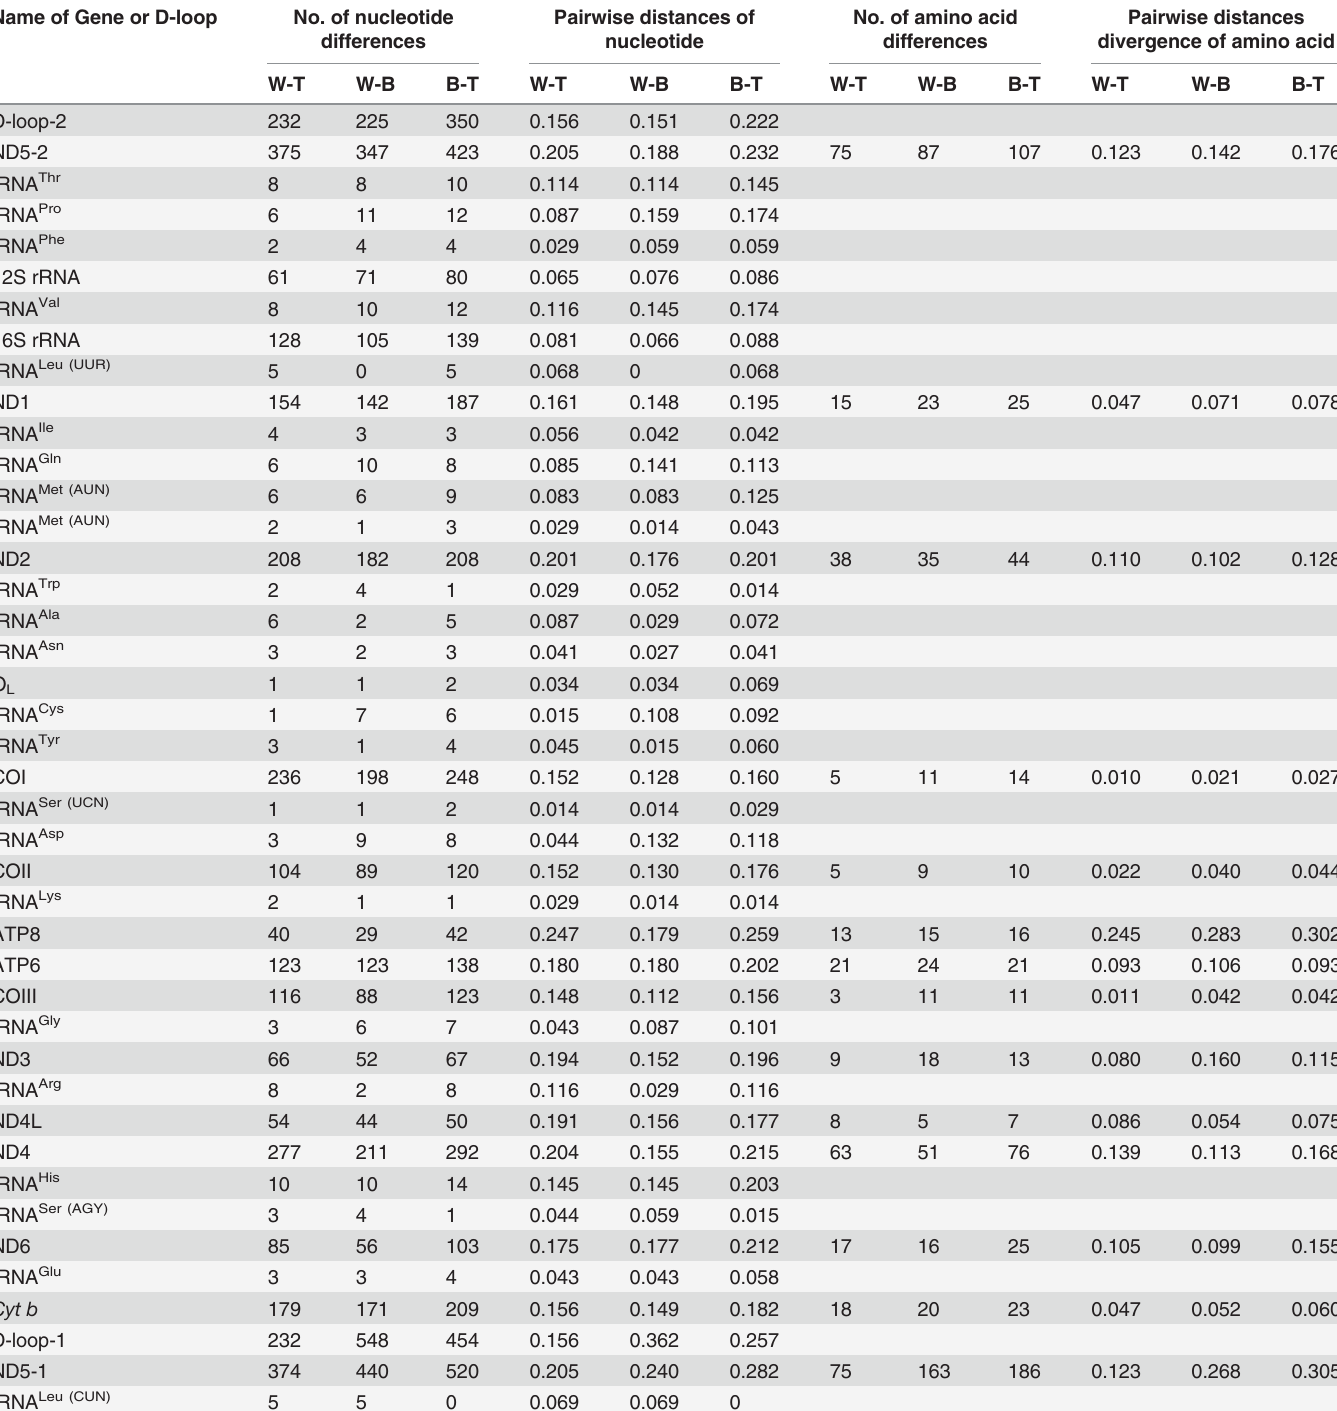
Table 4. Statistics describing the divergence ( p -distance) in mitochondrial genes between H . rugulosus wild type and H . tigerinus , between H . rugulosus wild type and bred type, as well as between H . rugulosus bred type and H . tigerinus . W: H . rugulosus wild type; B: H . rugulosus bred type; T: H . Tigerinus